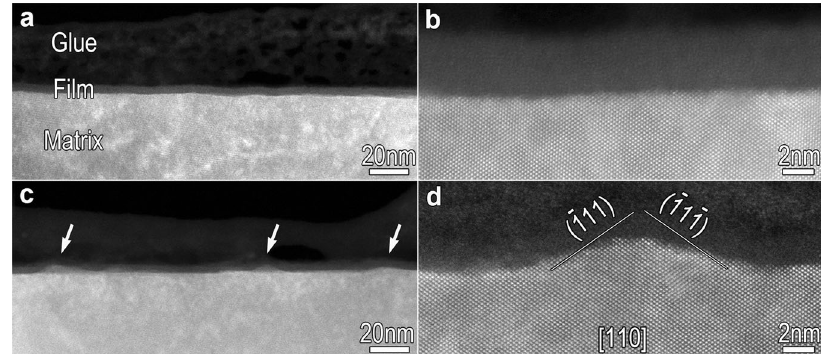
Fig. 1 Reductive dissolution of a passive fi lm in acid solution is evidenced experimentally. a , b HAADF-STEM ( a ) and HRHAADF-STEM ( b ) images showing the sharp, well-de fi ned, and straight Me/F interfaces of the passivated FeCr15Ni15 alloy. c , d HAADF-STEM ( c ) and HRHAADF-STEM ( d ) images of the passivated specimen on immersion in sulfuric acid (5.6 mol L − 1 ) for about 20 min clearly shows that the straight interface in the pristine passive fi lm becomes undulating. The walls of the swell are along the close-packed